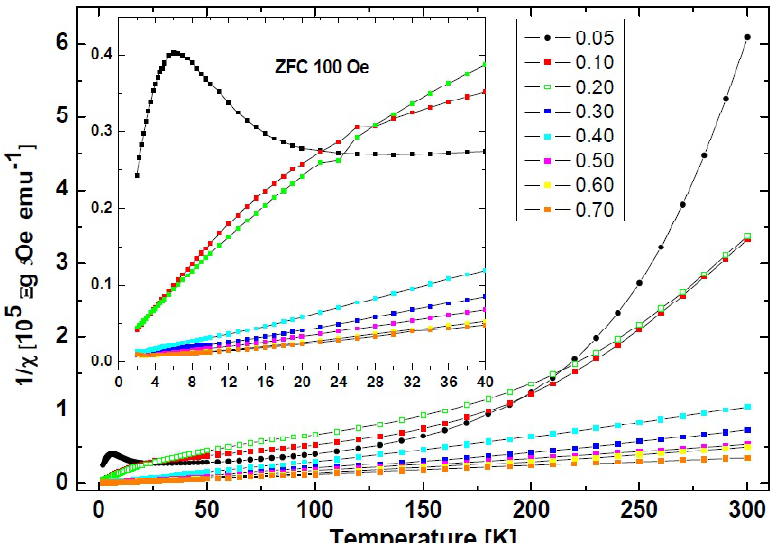
Fig. 2. Temperature dependence of the inverse magnetic susceptibility  -1 (T) for all investigated samples in magnetic field H = 100 Oe measured in ZFC mode. The insert shows magnified view of  -1 ( T ) curves in the low temperature